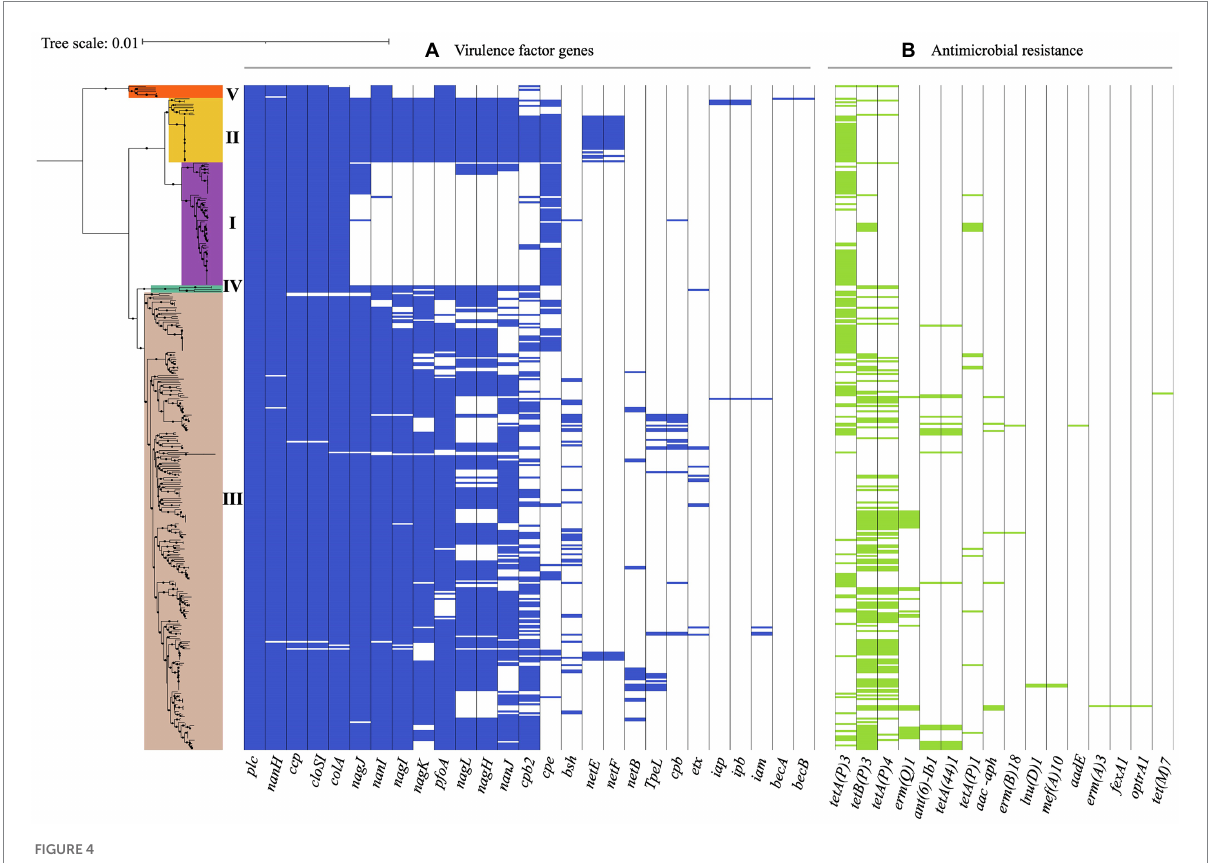
FIGURE 4 Virulence-associated and antimicrobial resistance (AMR) genes in 372 C. perfringens genomes. The core genome-based phylogenetic tree showed phylogroups highlighted in different colors. Matrix of absence and presence of genes shows (A) virulence genes (B) antimicrobial resistance (AMR) genes. The minimum coverage threshold needed for detection of these genes was 70% and the percentage of identity was 99.95%. The resulting trees were visualized and edited using iTOL v.5 (Letunic and Bork,